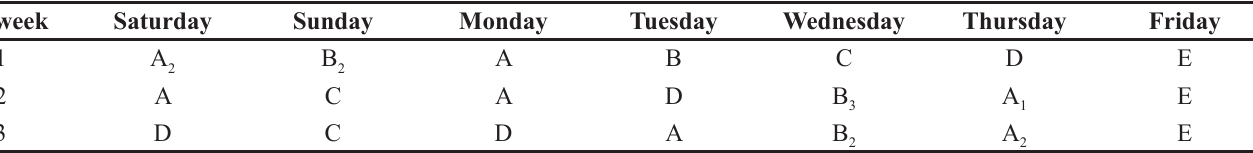
TABLE I - Weekly program for stress induction in experimental